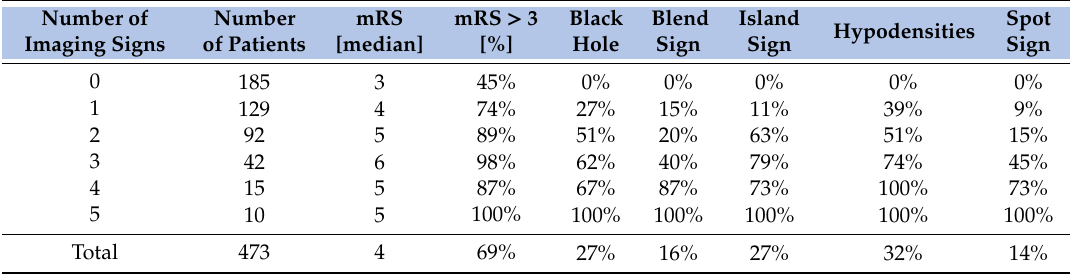
Table 3. Distribution of simultaneous appearance of imaging markers for early hematoma expansion in patients with spontaneous intracerebral hemorrhage.